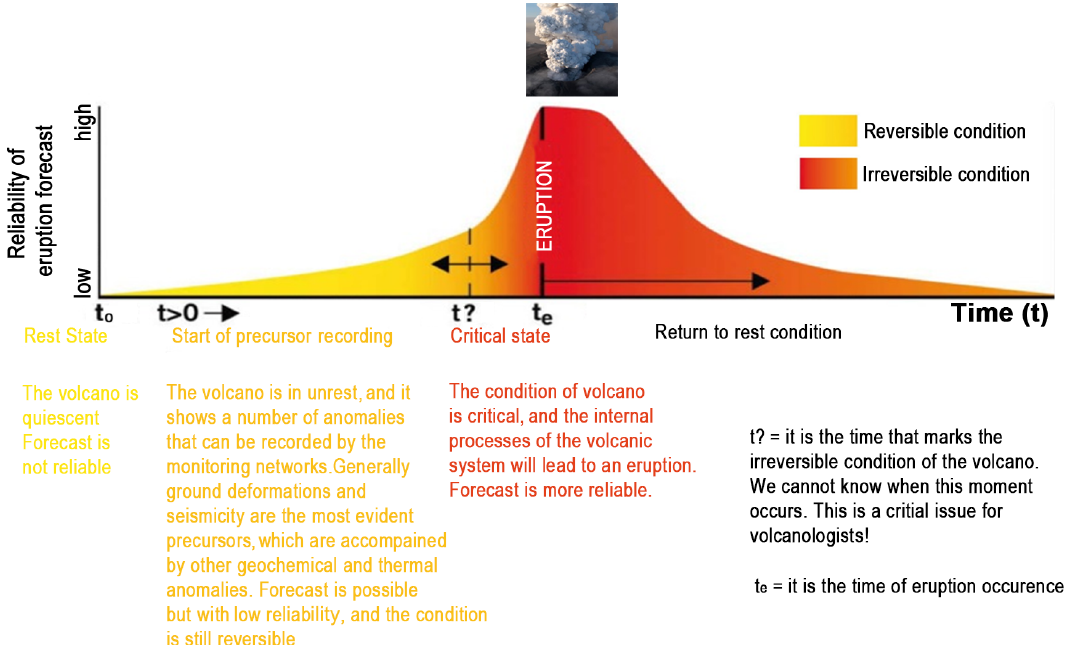
Figure 4. A qualitative sketch describing the possible state of a volcano approaching an eruption and its forecast reliability. For a quiescent volcano the reawakening is generally associated with the onset of seismic activity, indicating the variation in stress field within the volcano. The latter is generally due to circulation of pressurized fluids in the crust and, eventually, to magma migration at shallow level. This dynamic is accompanied by other precursors (ground deformations and variation in fluid emission) which make the forecast more reliable as the eruption is approached. The point at which the volcano overcomes the critical state is the moment ( t ?) in which the physical processes occurring within the volcano are irreversible, that is to say the volcano will erupt. Volcanologists cannot predict the time ( t ?) because the processes are chaotic, and the forecast has a probabilistic nature (after, Carlino,